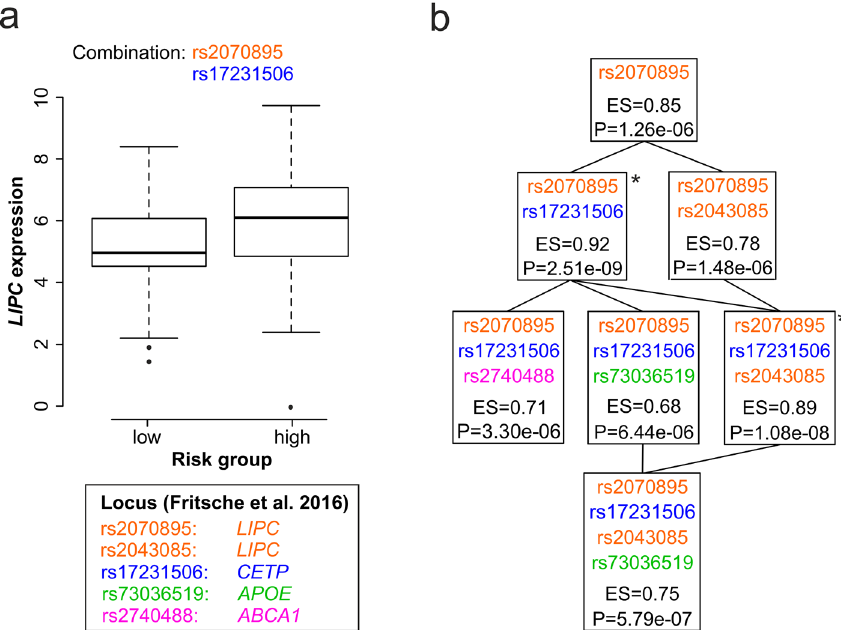
Figure 3. eCombinations altering expression of LIPC . ( a ) The boxplot compares LIPC expression between the AMD low and high-risk groups based on the genetic profile of the two genetic variants rs2070895 (orange, located in the LIPC locus) and rs17231506 (blue, located in the CETP locus). The y-axis corresponds to the relative level of gene expression. ( b ) The tree chart shows related variant combinations influencing the expression of LIPC . The chart starts with a single variant combination at the top and adds one variant per step downwards. Every box represents a set of variants used to determine risk groups. The P-value (P) and the effect size (ES) display the relationship between calculated risk groups and gene expression. Combinations highlighted with an asterisk remain significant after adjustment for multiple testing (Q-value < 0.05). Color code of variants refer to their locus